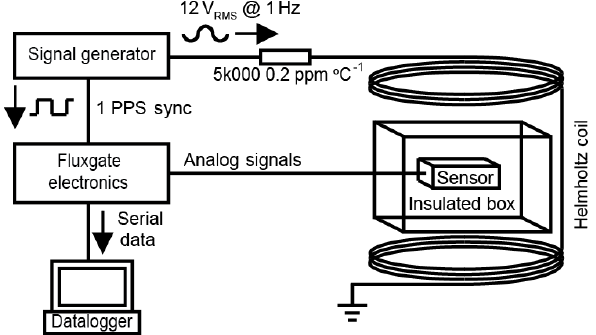
Figure 8. Experimental setup: each sensor was placed in an insulat- ing foam box within a Helmholtz coil. The coils were driven with a sinusoidal magnetic test signal, which was phase locked to the magnetometer electronics using the 1 pulse per second GPS timing input. Dry ice was used to cool the sensor and measurements were taken as the sensor warmed. The sensitivity of the sensor changes with temperature causing the measured amplitude of the constant test signal to vary with the sensor’s